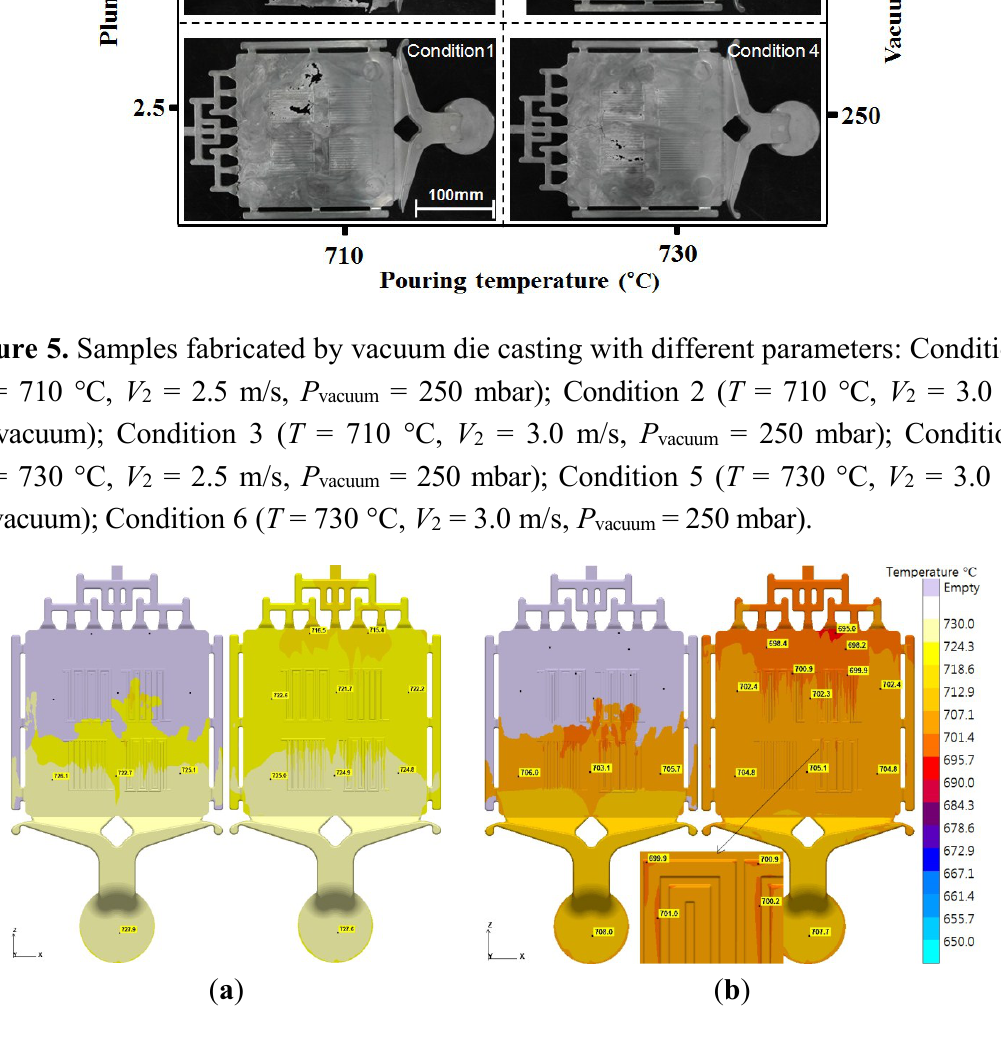
Figure 6. Temperature distribution in die cavity with different pouring temperatures during vacuum die-casting: ( a ) 730 °C and ( b ) 710